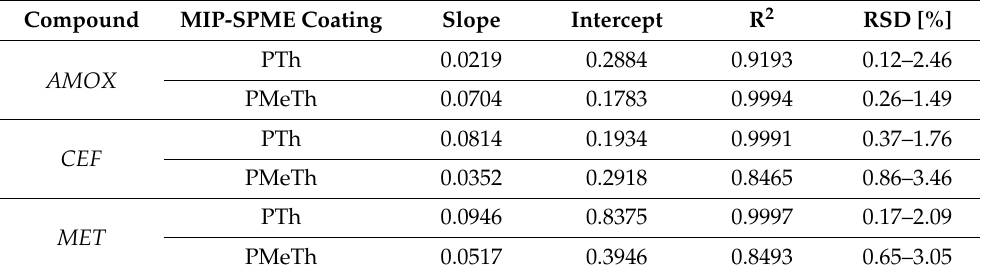
Table 3. Extraction efficiency for AMOX, CEF and MET in case of PTh and PMeTh SPME Coatings ( n = 6).